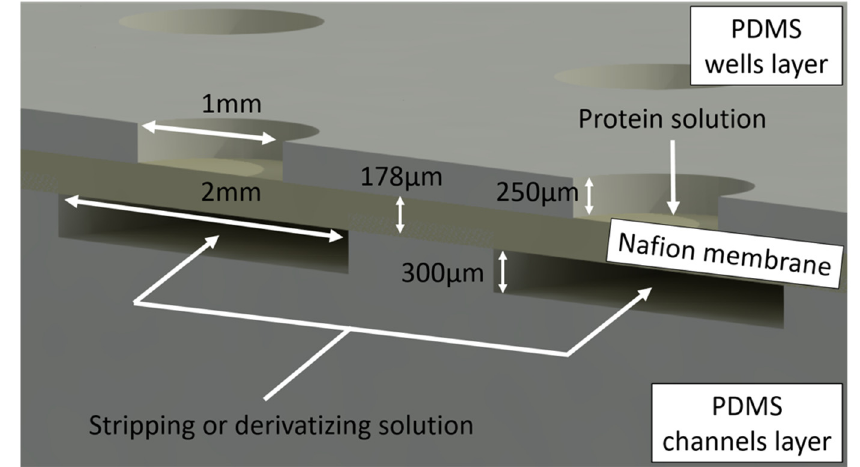
Figure 2. Cross-section scheme of the